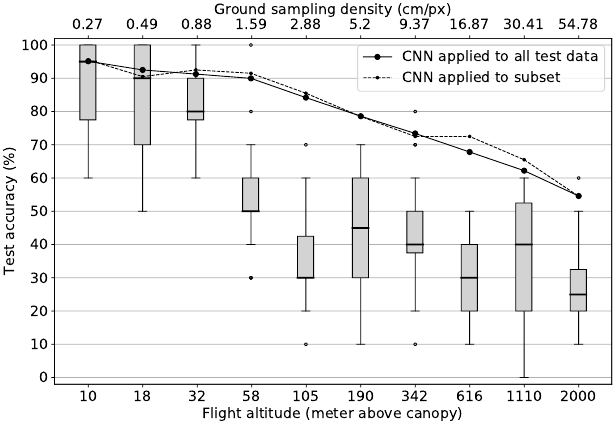
Figure 7. Validation accuracy after each epoch of the ten different models that were trained with successively decreased data resolutions corresponding to the flight altitudes listed.